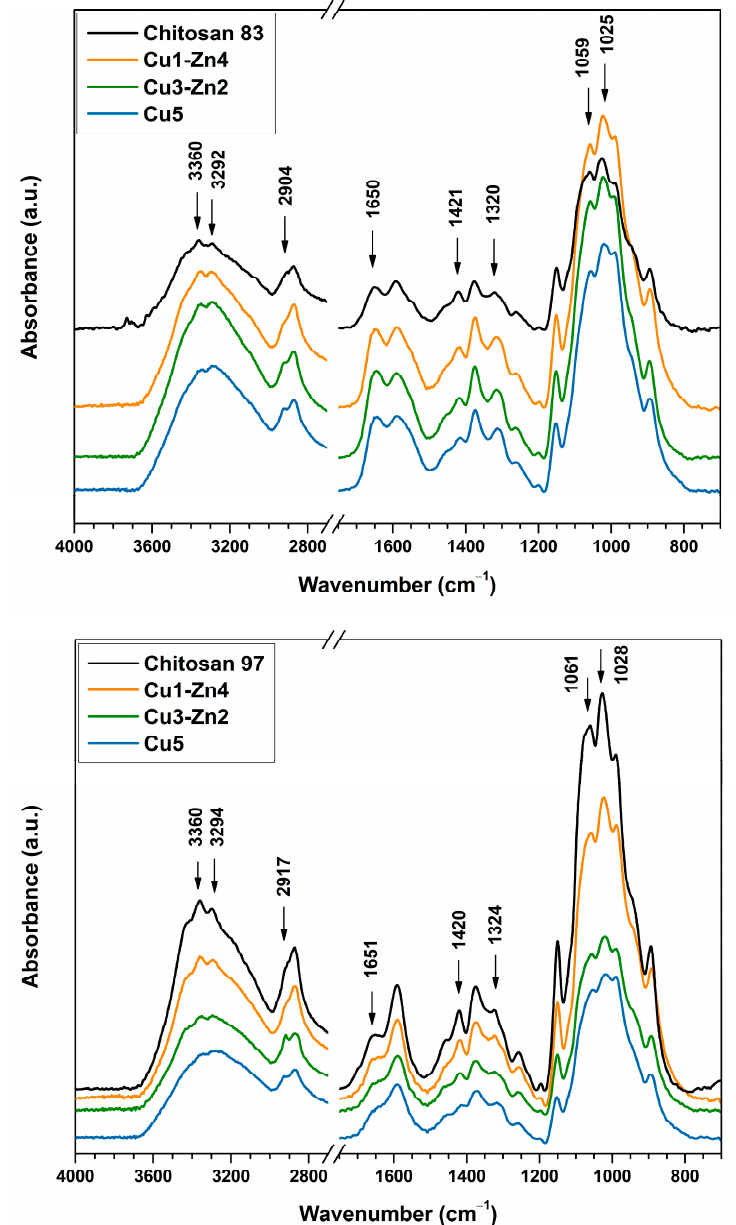
Figure 2. FTIR spectra of bimetallic chitosan dry microgels prepared with different contents of Cu 2+ and Zn 2+ ions.